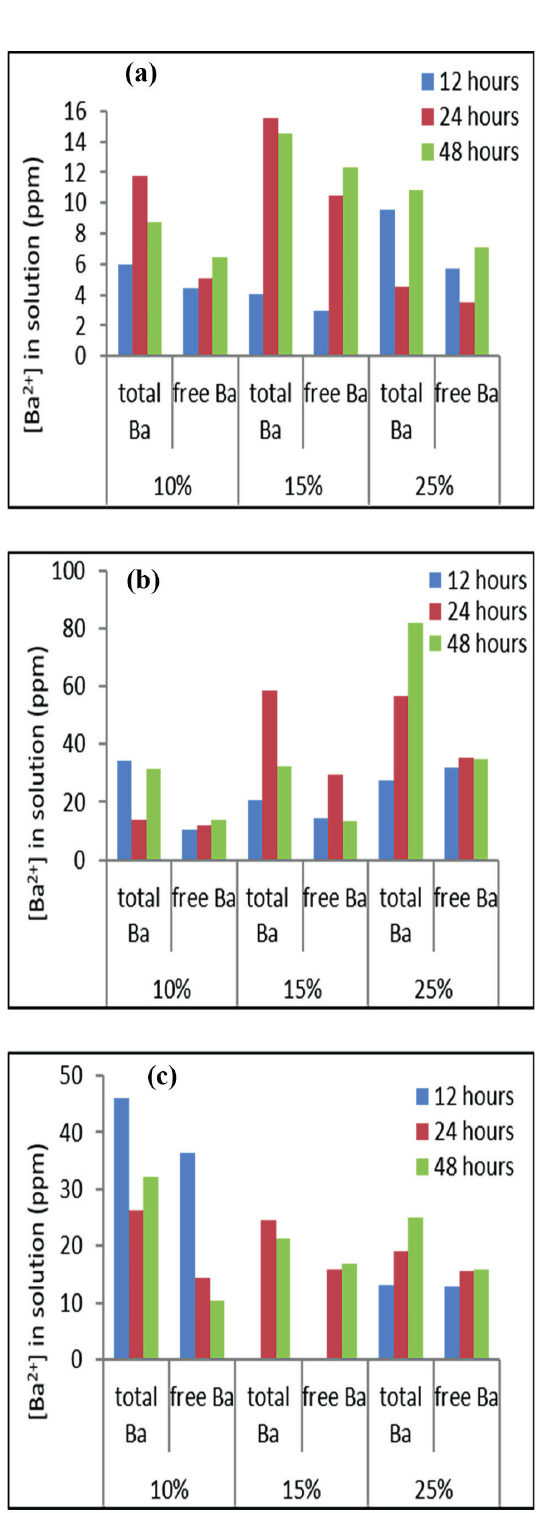
Figure 3 - Concentration (mg L -1 ) of total Ba 2 + and free Ba 2 + in supernatant at 23 °C ( a ), 50 °C ( b ) and 80 °C ( c ), analyzed by ion chromatography